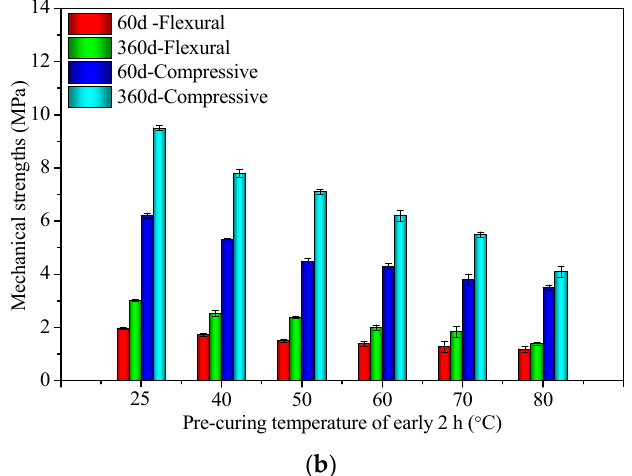
Figure 9. The flexural and compressive strengths of 60 d and 360 d for CS − FA − GEO composites: ( a ) with different CS contents, and ( b ) at different pre-curing temperatures.